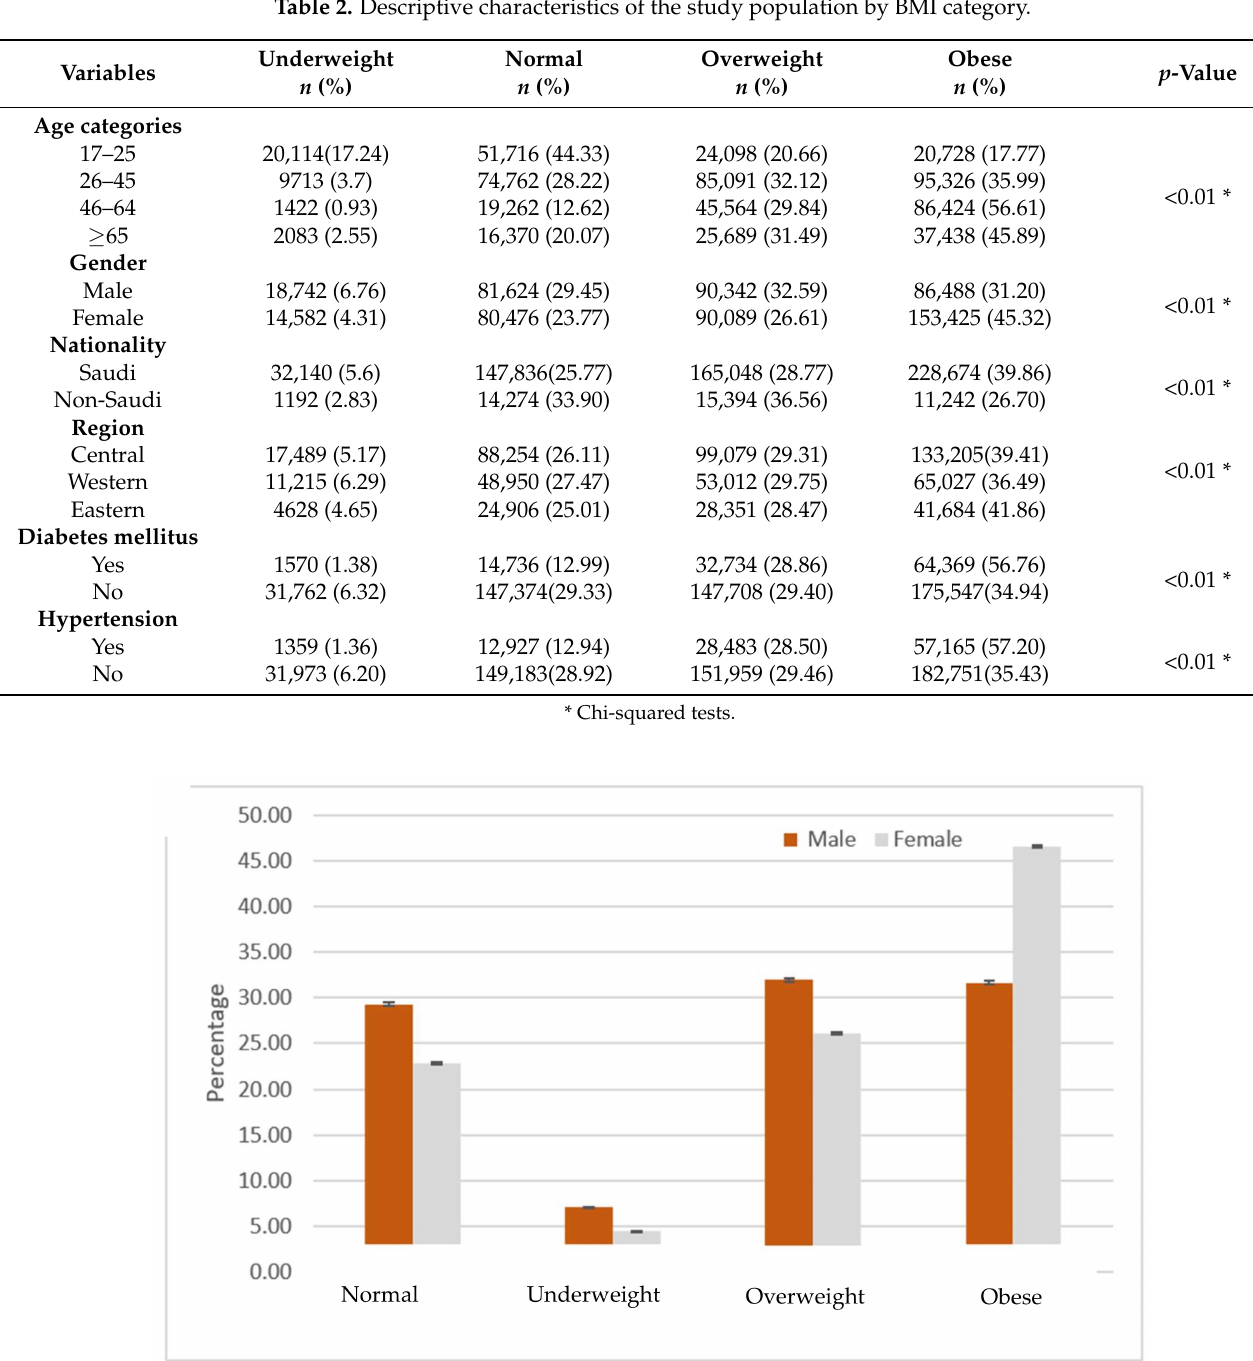
Figure 1. Prevalence of weight category by gender: Saudis ( n = 573,698). BMI was independently associated with diabetes mellitus in the multivariable logistic analysis. Obese individuals were significantly more likely to have diabetes than those with normal weight (OR = 2.24, 95% CI = 2.19, 2.28, p < 0.01). Age was also a predictor of diabetes. Versus those younger than 26 years old, those older than 65 years were approximately 27-fold more likely to have diabetes (OR= 27.36, 95% CI = 26.32, 28.45, p < 0.01). Males were 6% more likely to be diagnosed with diabetes than females (OR = 1.06, 95% CI = 1.05, 1.08, p < 0.01). Western and eastern regions had 26% lower odds of diabetes than